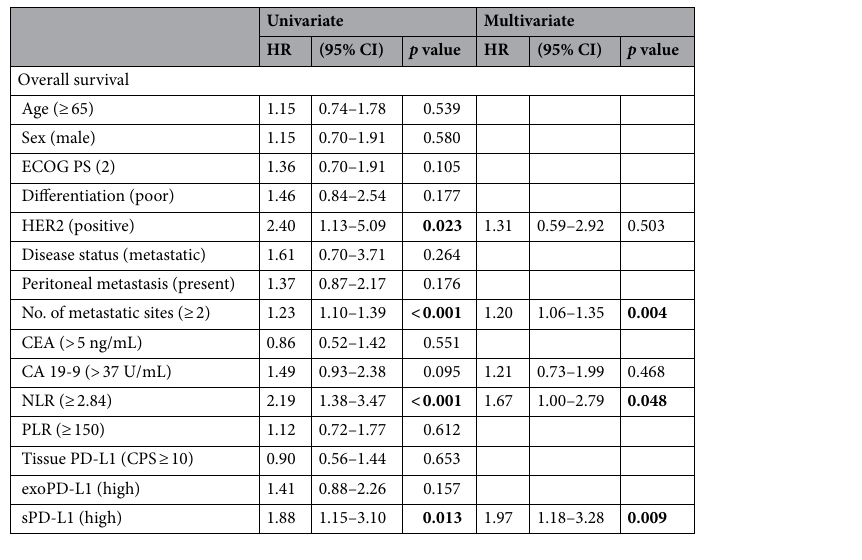
Table 2. Univariate and multivariate analyses for overall survival. Significant p -values < 0.05 are shown in